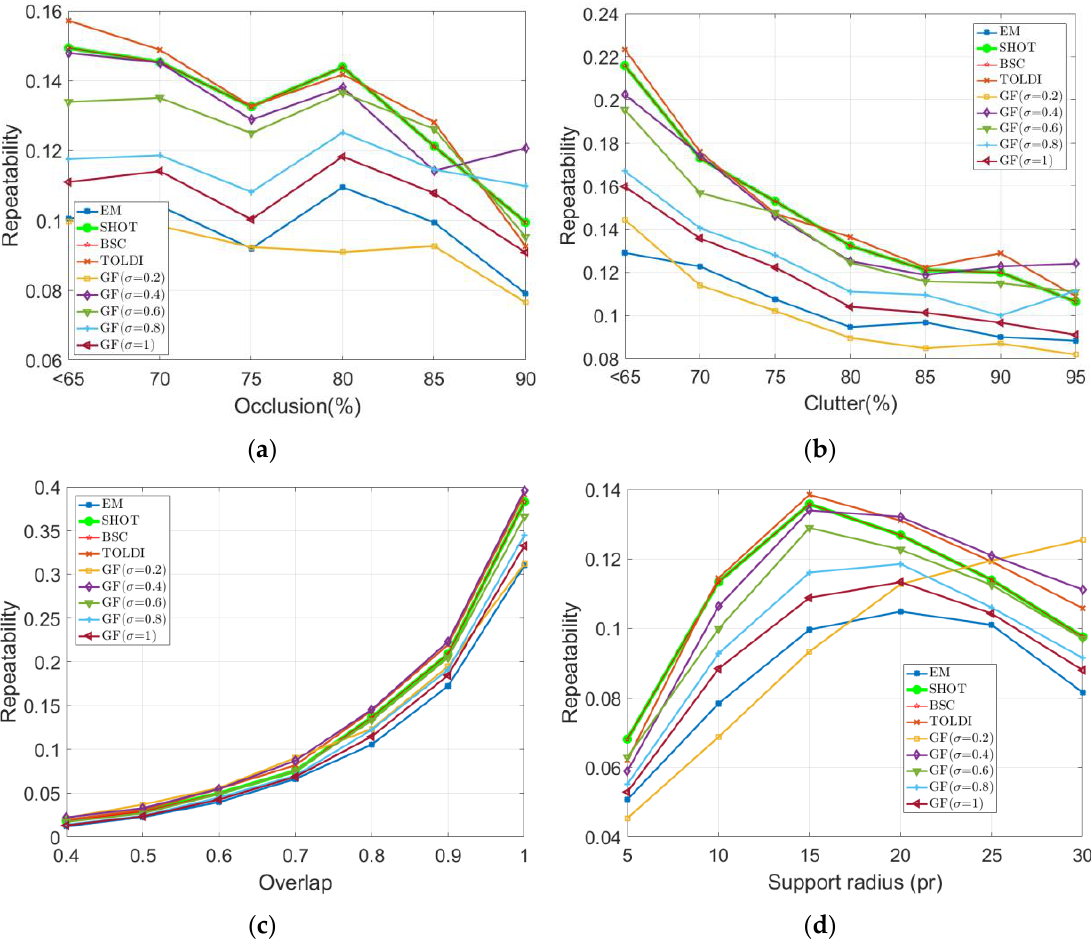
Figure 3. The repeatability of LRF obtained by the five weighting methods with respect to four kinds of nuisances, including ( a ) occlusion, ( b ) clutter, ( c ) partial overlap, and ( d ) varying support radii.